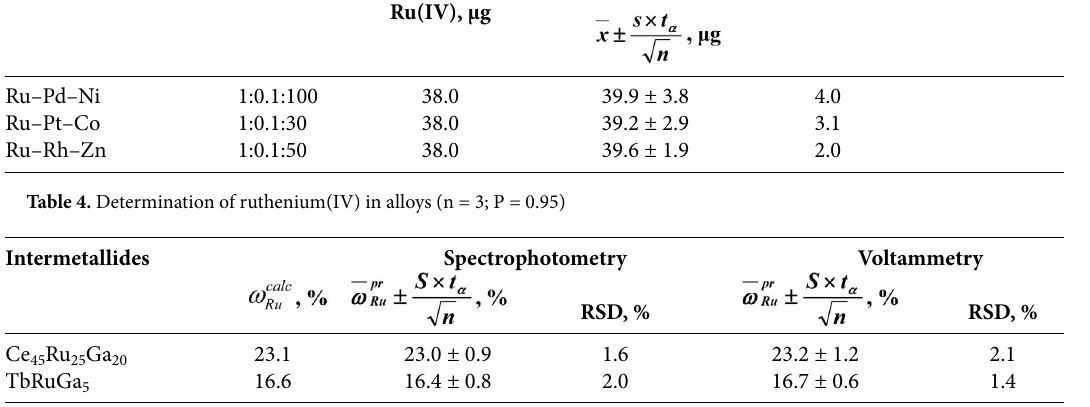
Table 3. Determination of Ru(IV) with HITO in synthetic solutions (n = 3; P = 0.95) Modeling solution